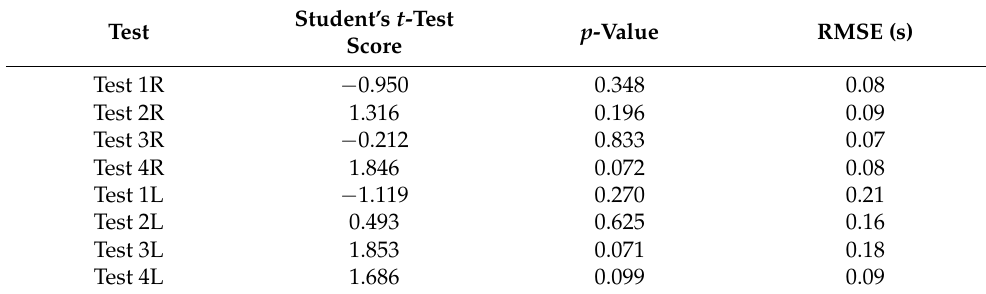
Table 3. Student’s t -test results for dependent sample and RMSE values for test run times measured by the FitLight Trainer and IMU device.